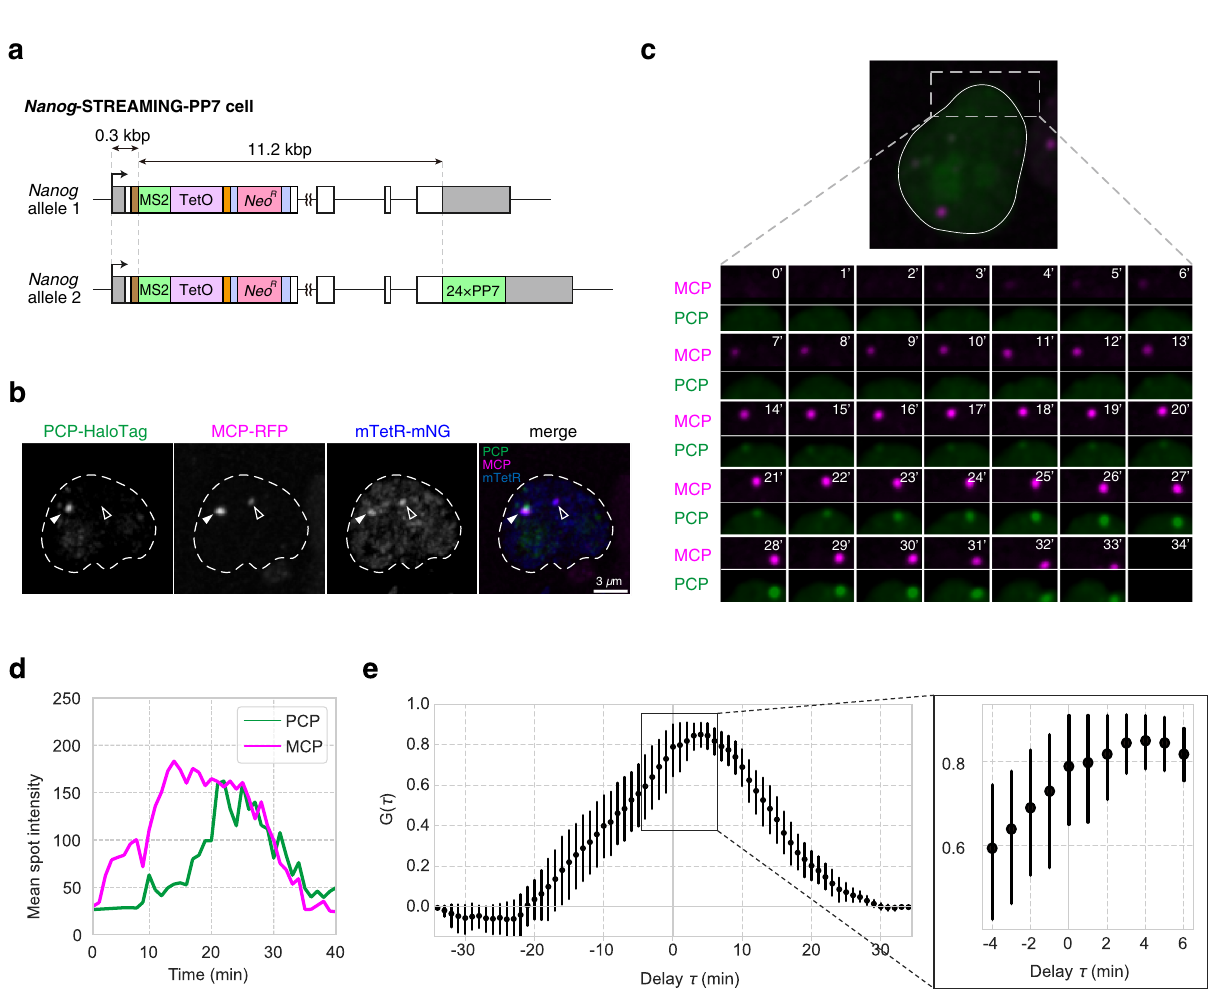
Fig. 5 | STREAMING-tag system enables quanti fi cation of transcriptional dynamicsneartranscriptionstartsite.a Structureofthe Nanog geneinacellline ( Nanog -STREAMING-PP7) in which the STREAMING-tag is knocked in biallelically near the TSS of Nanog and a PP7 repeat is knocked in monoallelically in the Nanog 3 ’ UTR. b A cell line derived from Nanog -STREAMING-PP7 cells and stably expres- sing MCP-RFP/PCP-HaloTag/mTetR-mNG was established and subjected to live imaging. Representative images of a cell in which MCP-RFP, PCP-HaloTag, and mTetR-mNG spots were observed. Filled white arrowheads indicate locations